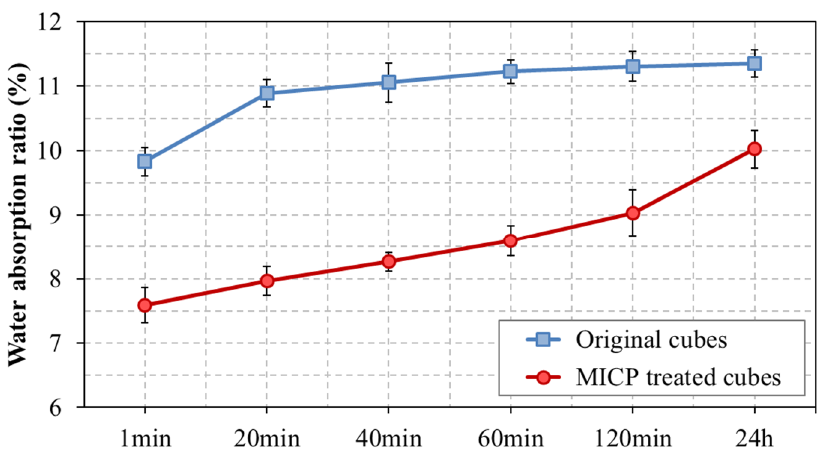
Figure 5. Influence of immersion time on water absorption. Each measurement represents the mean of three replicate samples and bars indicate standard deviation.